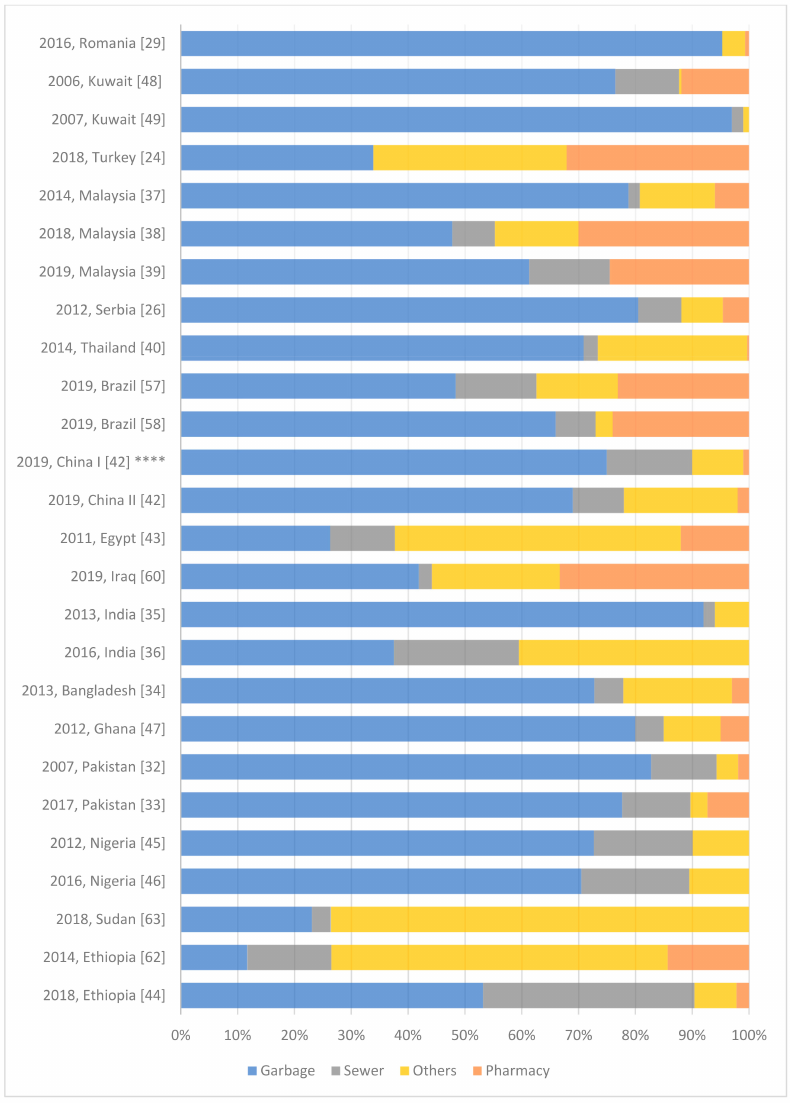
Figure 1. Disposal practice of unused medication among people as reported by peer-reviewed literature. * the survey was conducted in two countries (Ireland and Malta), and results were presented for both countries together. ** many of the respondents (38.0%) dispose their medications in the recycling places and toxic waste bins, which considered as eco-friendly routes and combined with the pharmacy answers. *** two surveys were carried out: Survey I concerned households; Survey II focused on pharmacies. **** the study was conducted over two samples (Young-Adult I and Elderly